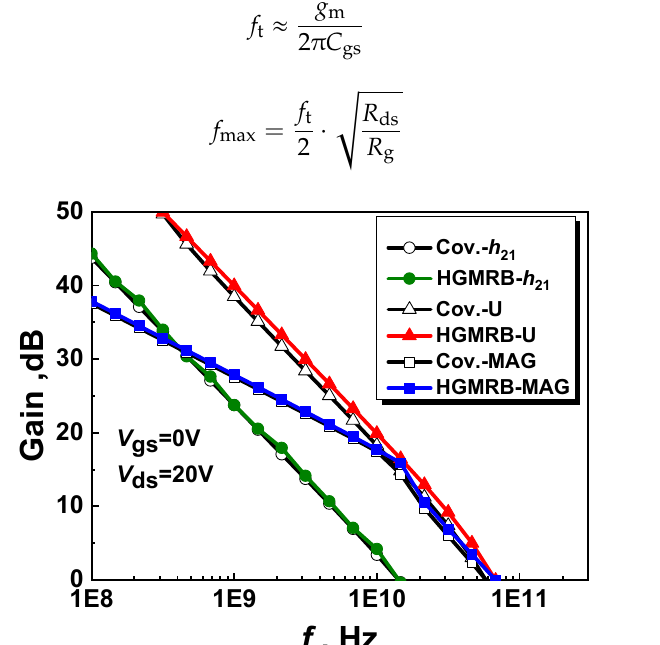
Figure 8. Small-signal high-frequency characteristic curve of two devices at V gs = 0 V, V ds = 20 V.